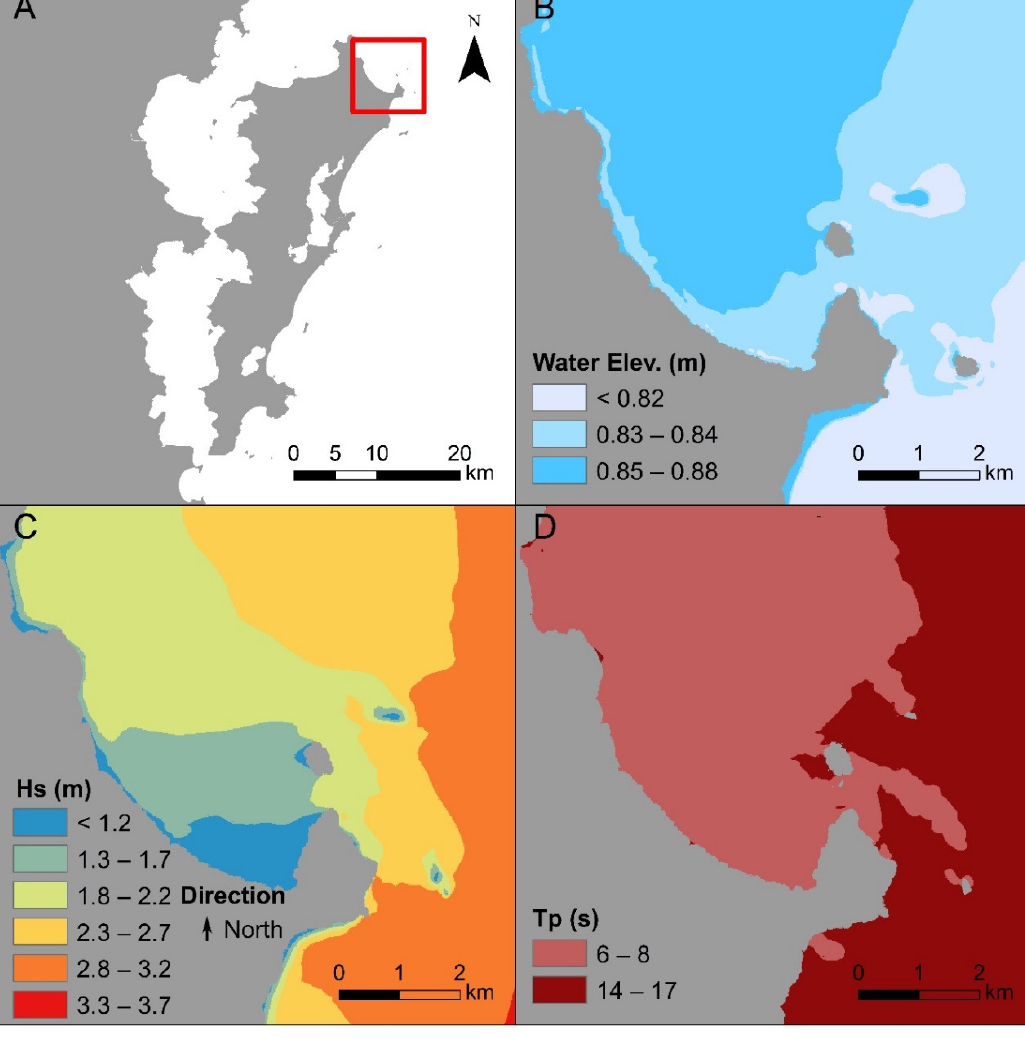
Figure 13. ( A – D ) Local-scale assessment of models’ maximum outputs during Storm 1 (gray portions represent land).